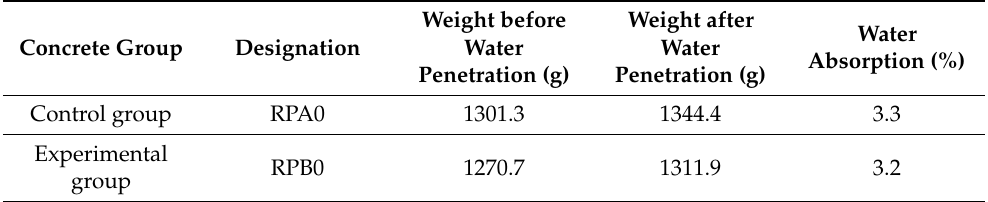
Table 26. Penetration test results of concrete at room temperature.